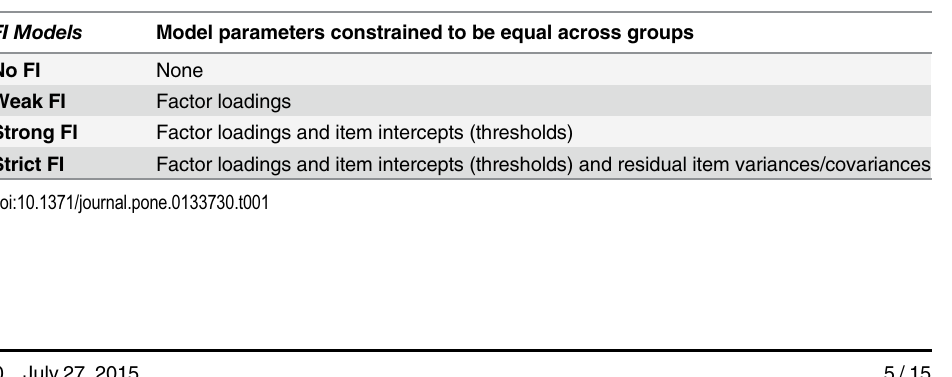
Table 1. Levels of factorial